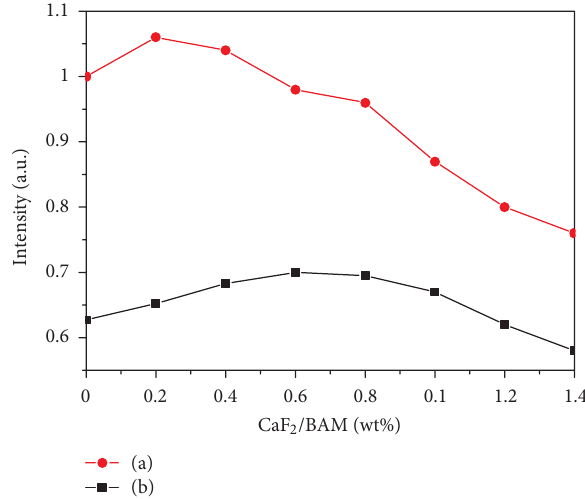
Figure 3: Emission intensities of CaF 2 -coated BAM phosphors as a function of the weight ratio CaF 2 /BAM (a) before heat treatment and (b) after 600 ∘ C heat treatment ( 𝜆